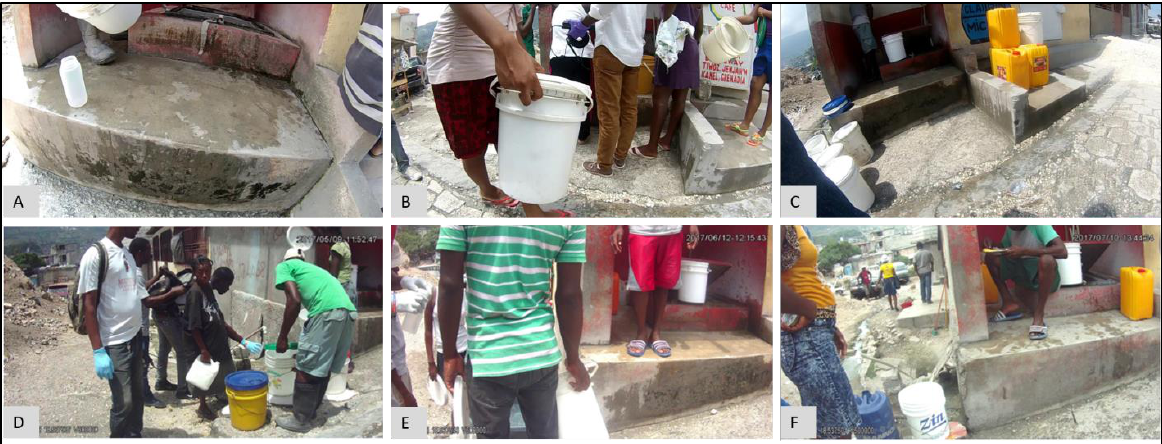
Figure 15. SV images for water point S17 for: ( A ) February, ( B ) August, ( C ) September, ( D ) May, ( E ) June, and ( F ) July 2017.